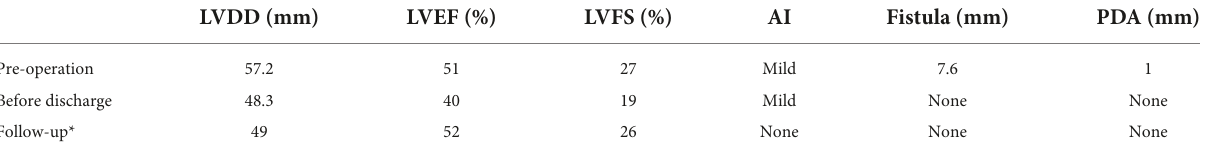
TABLE 1 Cardiac phenotypes of the patient carrying